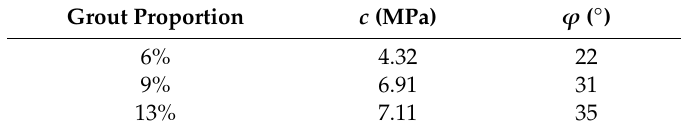
Table 1. Average cohesion, c , and internal friction angle, ϕ , of the gangue specimen.